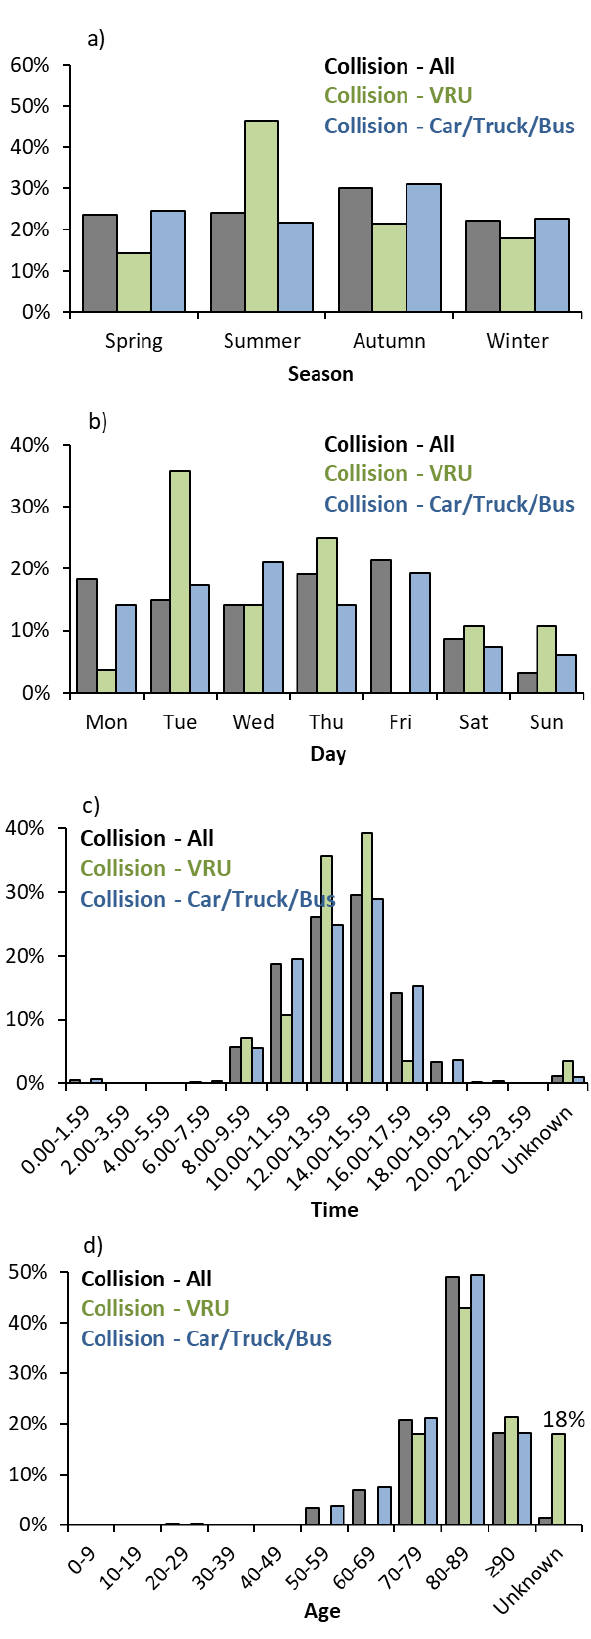
Figure A4. The distribution of a) season, b) day, c) time, and d) age of the driver in powered mobility devices (PMD collisions. Grey bars: all collisions (n=352), green bars: VRU collisions (n=322), blue bars: car/truck/bus collisions